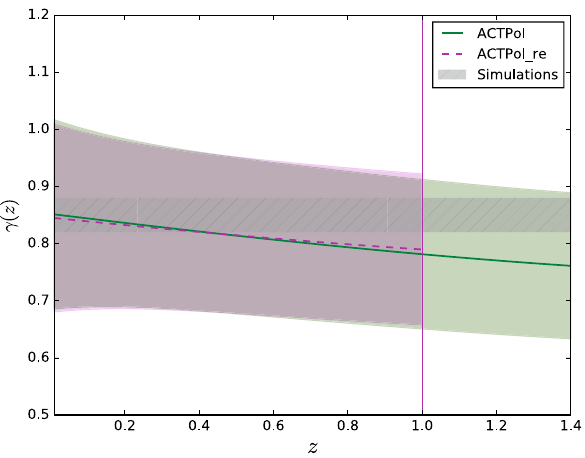
Fig. 3 Reconstructed gas depletion factor γ( z ) for the full (green solid line) and reduced (magenta dashed line) ACTPol cluster sample, with the shadow regions showing the 1 σ region calculated with the error propagation.Thegraydashedregioncorrespondstothehydrodynamical simulation